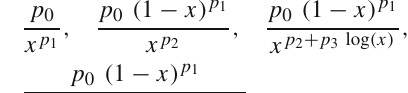
Fig. 1 Distribution of the soft-drop PUPPI mass after the kinematic selections on the two jets, for data, simulated background, and signal. The signal events with low mass correspond to boson decays where one of the two quarks is emitted outside the jet cone or the two quarks are overlapping. The distributions are normalized to the number of events observed in data. The dashed vertical lines represent the boundaries between the jet mass